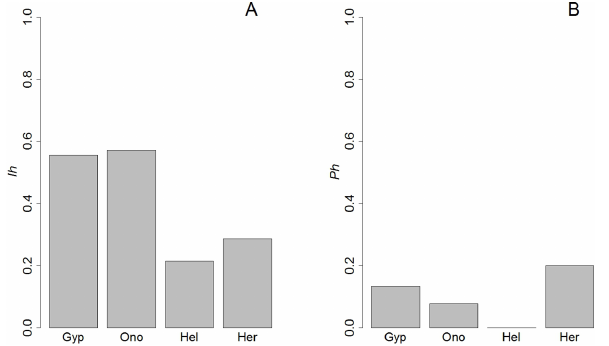
Figure 3. Importance of gypsophytes in the plant association net- works at the four study sites in the middle Ebro Valley, Spain. Study site refers to the sites with the lowest (L) and the highest (H) aridity index values and whether a site was grazed (G) or ungrazed (U). (A) Proportion of times that plant species appeared in a high in- trapartition degree group (Ih) at each study site. (B) Proportion of times that plant species appeared in high participation group (Ph) at each study site. Bars include the proportion of times that a gyp- sophyte (dark bars) or a nongypsophyte (light bars) appeared in a high value group (Ih and Ph). Nonsignificant differences between gypsophytes and nongypsophytes at each site are represented by ns, while marginally significant differences ( p values<0.1) are repre- sented by “ • ”.